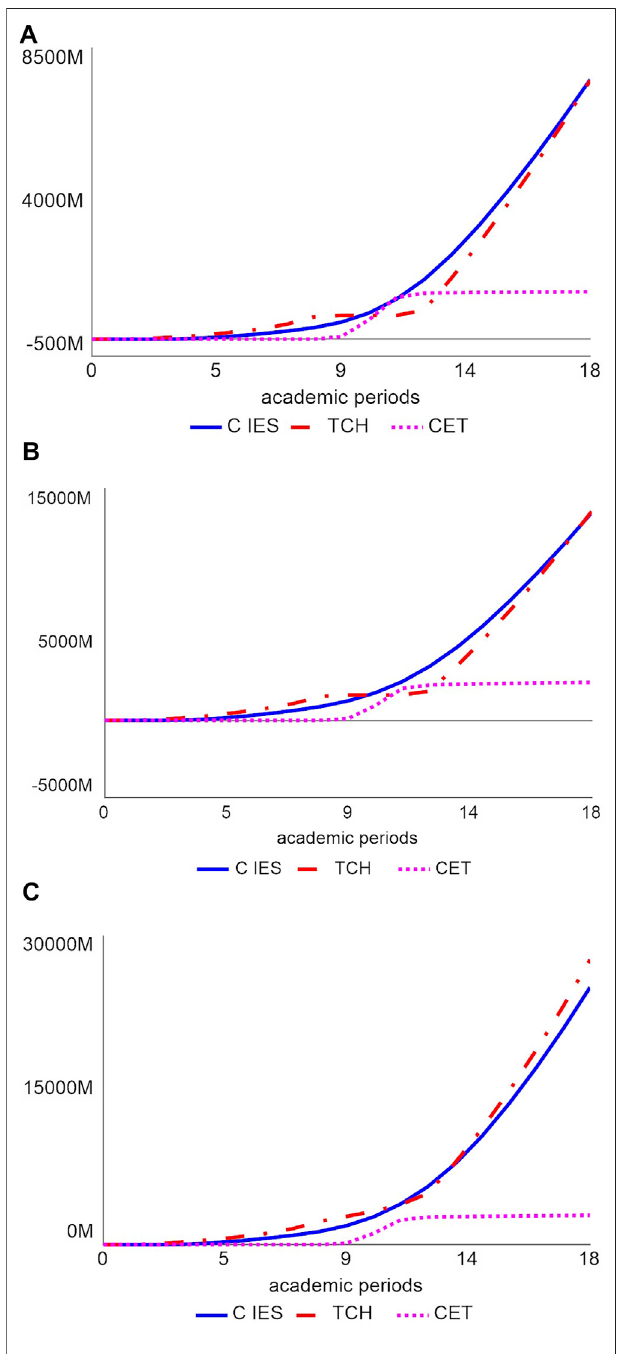
FIGURE 5 | Behaviour of the economic effects of drop-out for SIM-1. Note: (A) presents technical training programmes, (B) technological training and (C) professional training. C IES: Total cost for the training programmes under study per t . THC: Stranded cost for the family per t . CET: Total cost for the State per t